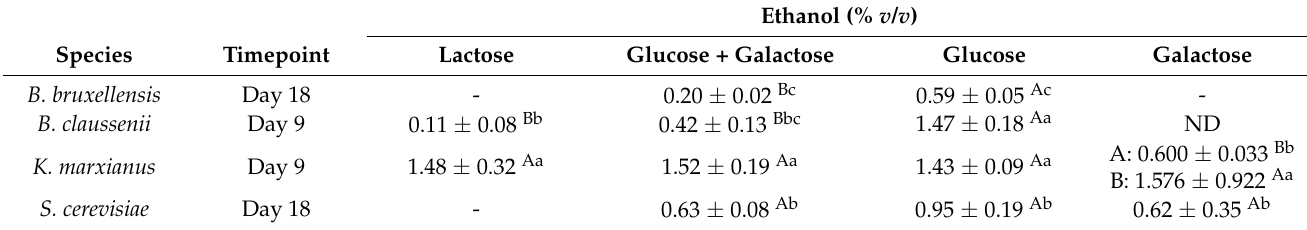
Table 2. Final concentrations of ethanol (% v / v ) in fermentates containing sugars associated with acid whey; fermentates were held at 25 ◦ C and subjected to shaking at 185 rpm. Means and standard deviations are provided, representing biological triplicates, with the exception of values associated with K. marxianus , for which a fourth replicate was included in the experiment. Ethanol (% v / v )